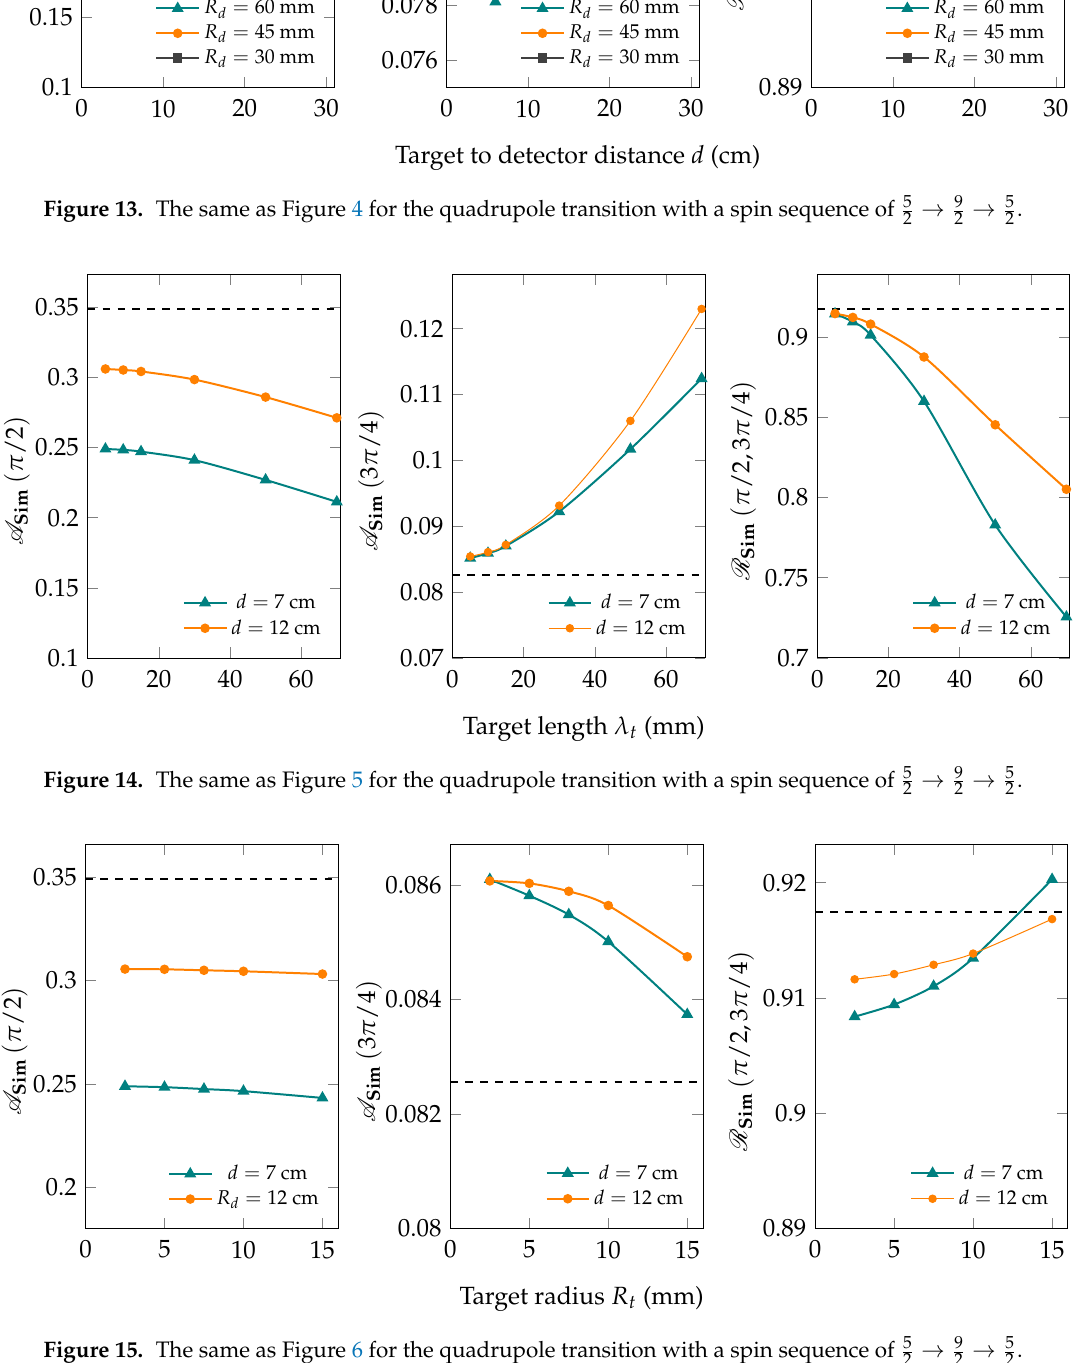
Figure 15. The same as Figure 6 for the quadrupole transition with a spin sequence of 5